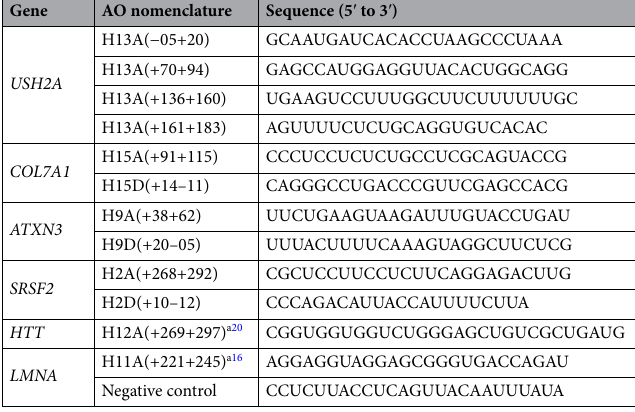
Table 3. Information for AOs. a Not tested in this study; published results.